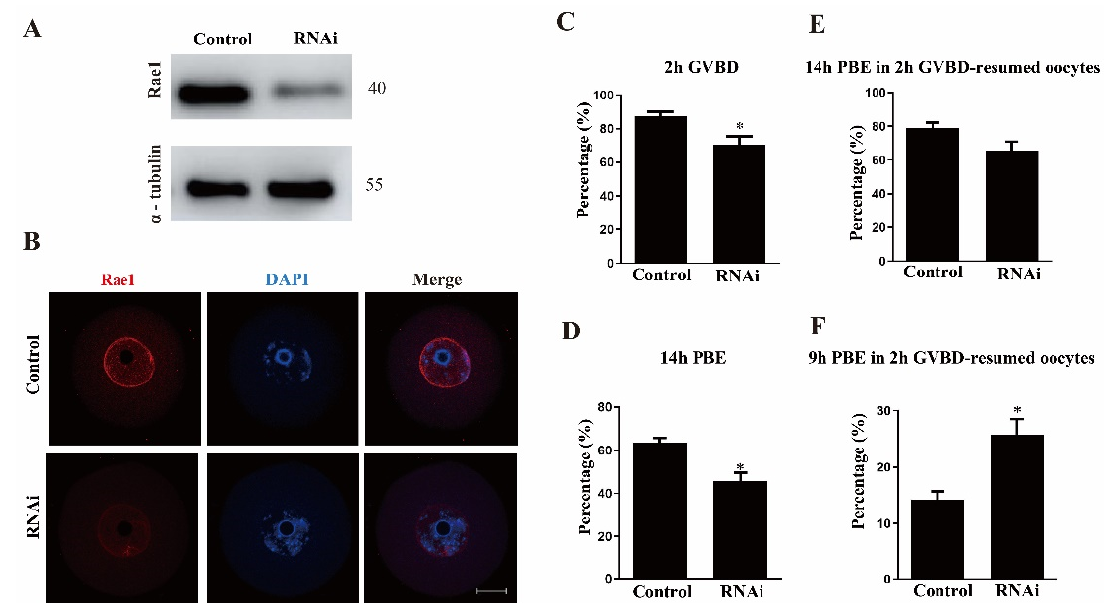
Figure 2. Rae1 knockdown affects the meiotic maturation process. ( A ) Efficiency of Rae1–RNAi after siRNA microinjection was verified by immunoblotting. ( B ) RNAi after siRNA microinjection was verified by immunostaining. Rae1 is shown in red and DAPI in blue. Scale bar = 20 µ m. ( C ) The GVBD rates in the control group and Rae1 knockdown group were recorded 2 h after release from 3-Isobutyl-1-Methylxanthine (IBMX) arrest. * p < 0.05. ( D ). The PBE rates in the control group and Rae1 knockdown group were recorded 14 h after release from IBMX arrest. * p < 0.05. ( E ) The PBE rates in the control group and Rae1 knockdown group were recorded after 14 h in 2 h GVBD-resumed oocytes after release from IBMX arrest. p > 0.05. ( F ) The PBE rates in the control group and Rae1 knockdown group were recorded after 9 h in 2 h GVBD-resumed oocytes after release from IBMX arrest. * p < 0.05. The data are presented as mean ± SEM of at least three independent experiments.